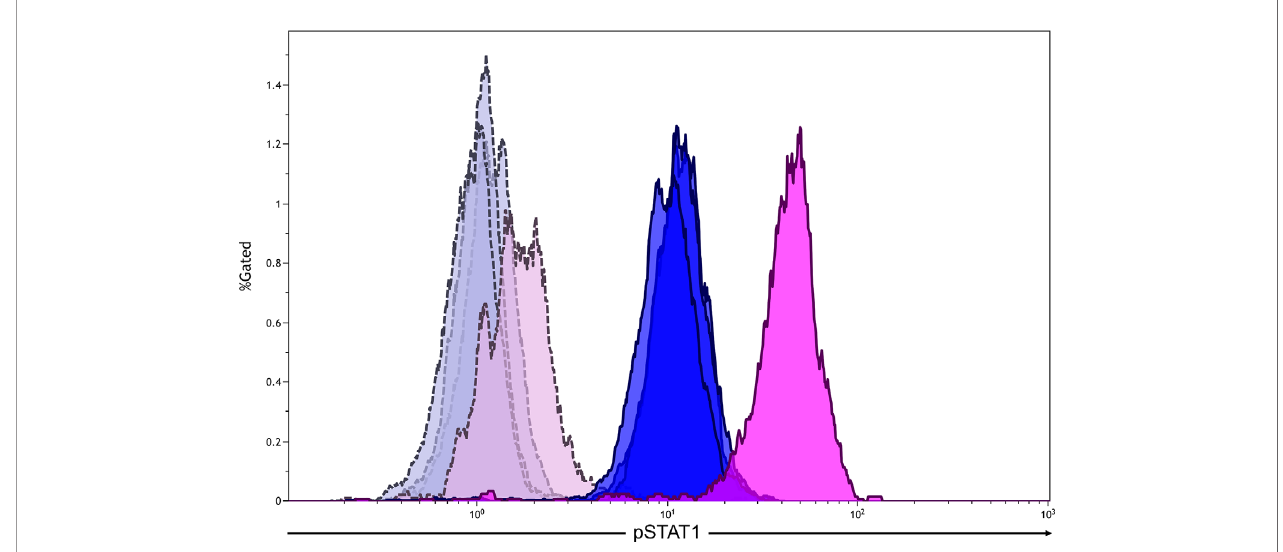
FIGURE 2 | Flow cytometric analysis of phosphorylationed STAT1 (pSTAT1) in monocytes after the stimulation with interferon- g (500 U/mL). The analysis gate was set in CD14 + cells. Blue areas indicate healthy adults (n = 3), whereas pink areas indicate the patient. Gray and purple areas indicate pSTAT1 in monocytes without interferon- g stimulation in healthy adults and the patient, respectively.